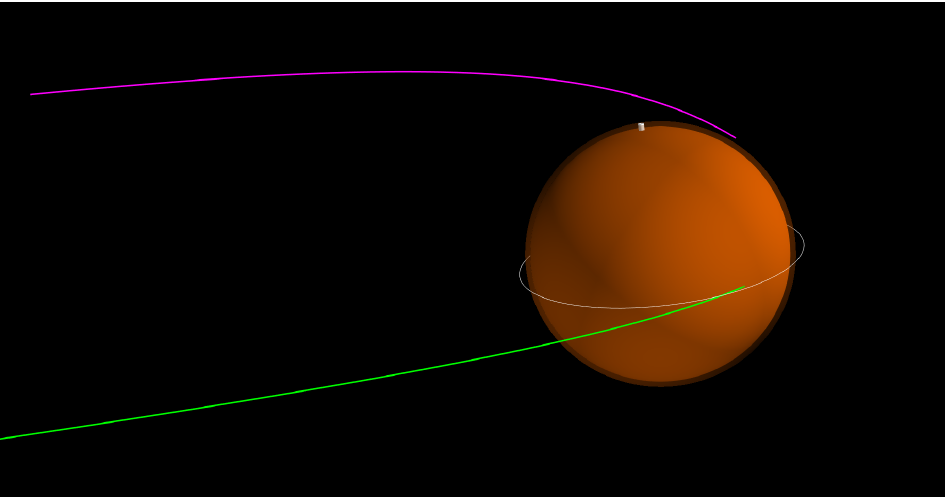
Figure 14. Hyperbolic near-equatorial approach trajectory of the Mars SmallSat (green), and the polar approach trajectory of the host orbiter spacecraft (magenta) until periapsis. The host orbiter performs a 790 m/s propulsive burn into its 250 × 70,000 km polar orbit. Figure 15 shows the two spacecraft in their capture